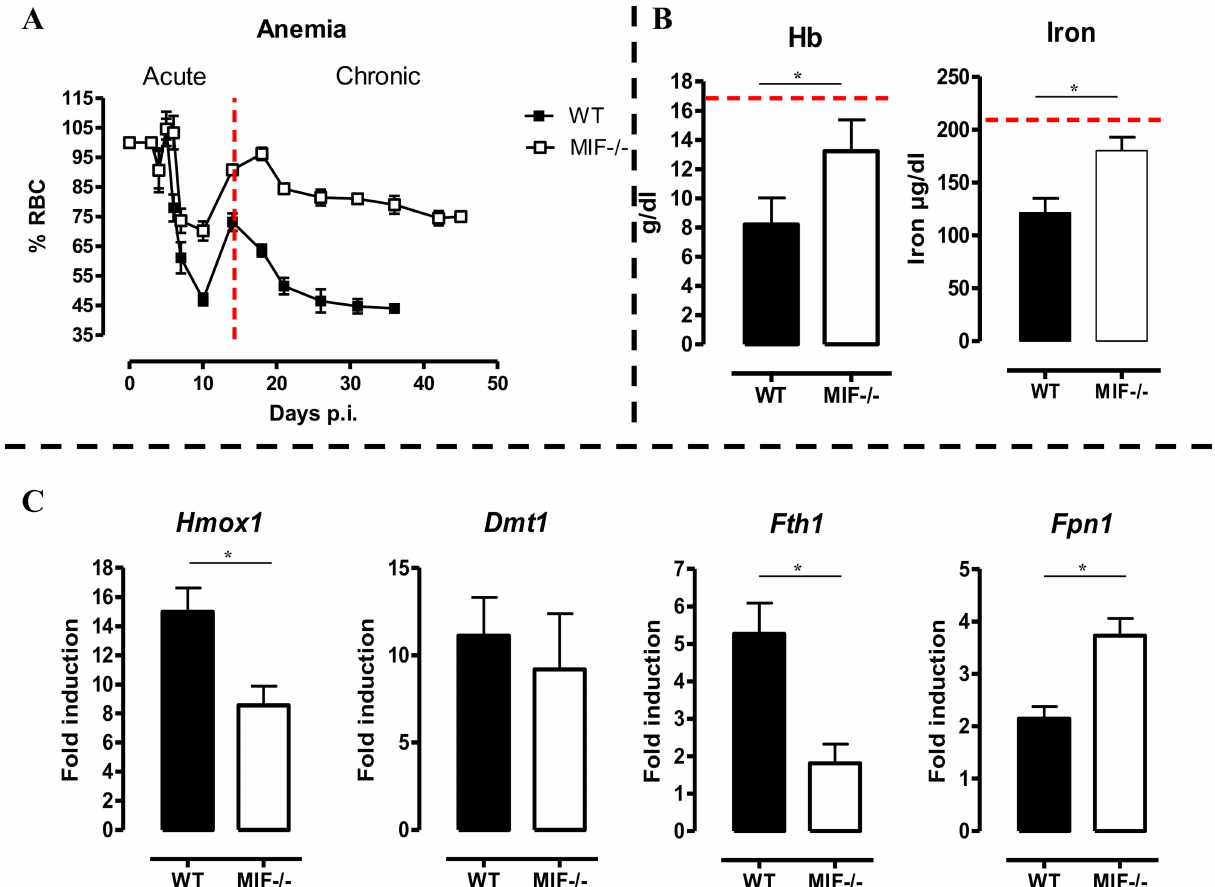
Figure 6. MIF deficiency correlates with reduced anemia, restored hemoglobin/serum iron levels and restored iron homeostasis during T.brucei infection. (A) Anemia development during infection in C57Bl/6 (WT, black box; Mif 2 / 2 , white box) mice. Results are representative of 2–5 independent experiments and expressed as mean of 3–5 individual mice 6 SEM. (B) At day 18 p.i., (left panel) hemoglobin levels and (right panel) serum iron levels in Mif 2 / 2 (open bars) and WT (black bars) mice. (C) Expression levels of the iron-homeostasis associated genes Hmox1 (iron import), Dmt1 (iron transport), Fth1 (iron storage) and Fpn1 (iron export) were quantified by RT-QPCR in total livers from Mif 2 / 2 (white bars) and WT (black bars) mice at day 18 p.i. Gene-expression levels are normalised using s12 and expressed relatively to expression levels of non-infected mice. Results are representative of 2 independent experiments and presented as mean of 3 individual mice 6 SEM (*: p-values # 0.05).